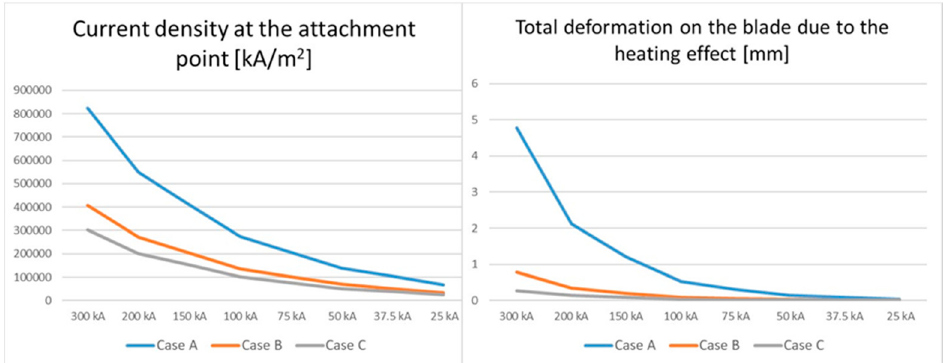
Figure 5. Current density ( left ) and total deformation of the blade ( right ) for the conventional case studies.